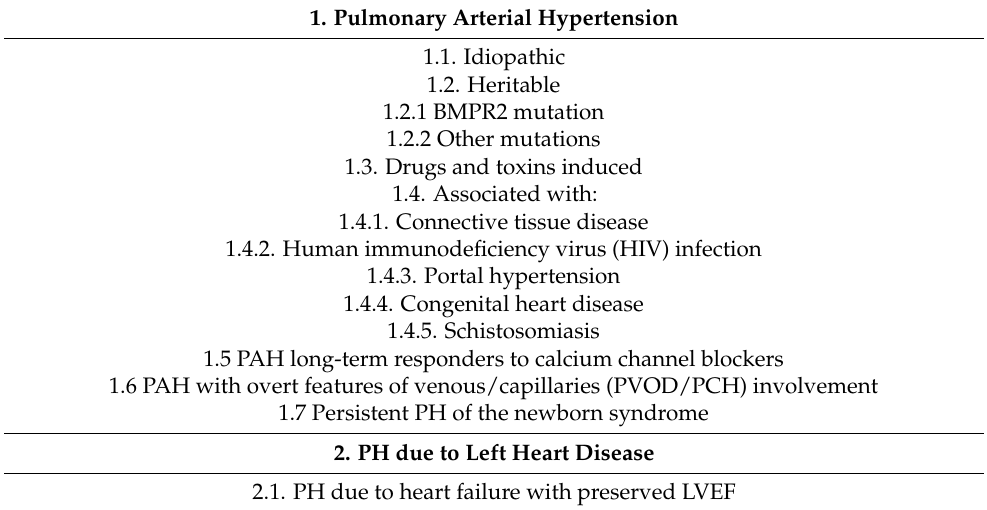
Table 2. Clinical classification of pulmonary hypertension (PH). Adapted from